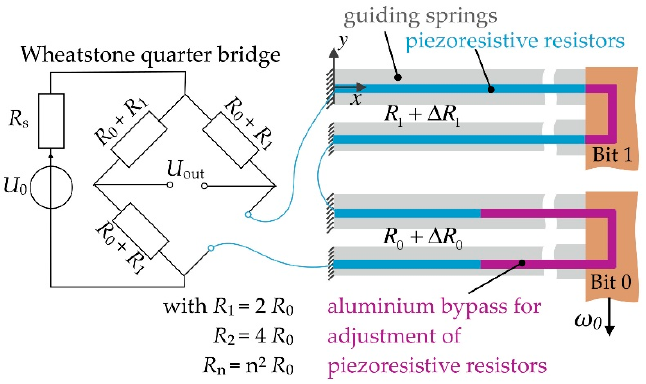
Figure 3. Schematic of the MEMS digital-to-analog converter using a quarter Wheatstone